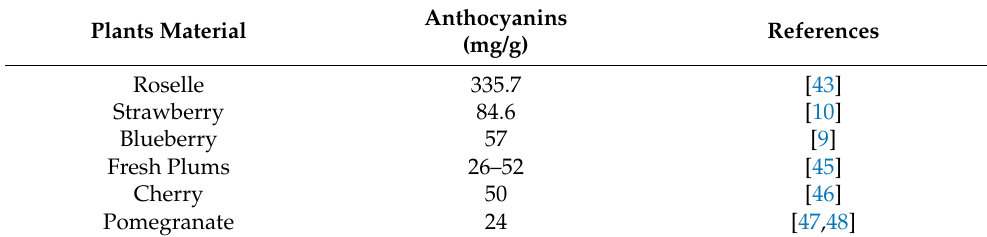
Table 2. Anthocyanins concentration from other